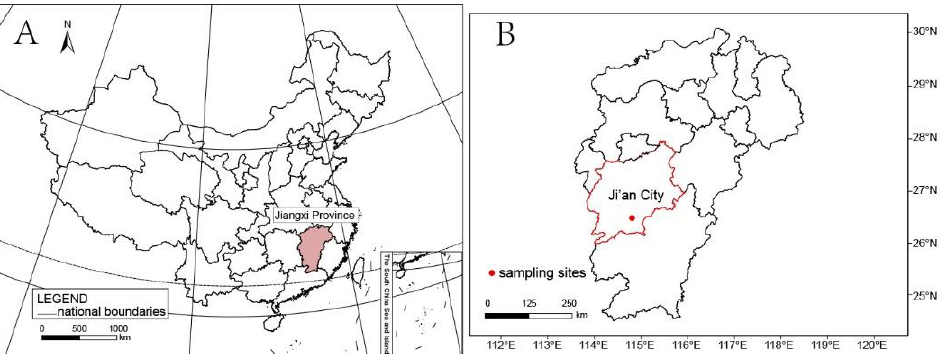
Figure 1. Collection site. A. Jiangxi Province is colored with pink. B. Ji’an City is circled with a red line and the collection site is marked with a red solid circle.